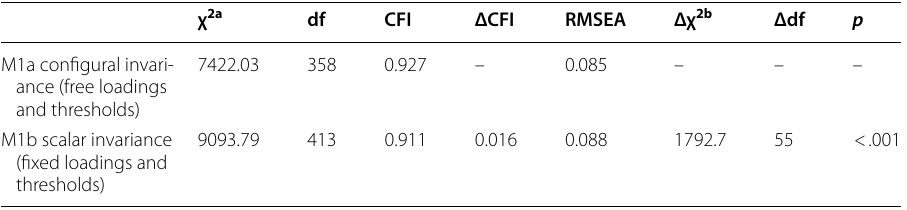
Table 5 Testing measurement invariance between girls and boys for ICT Engagement scales for